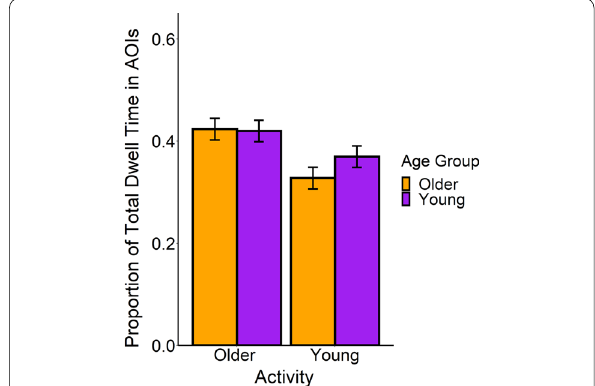
Fig. 3 Proportion of total dwell time spent in the goal-relevant AOIs. Young adults spent more time in the goal-relevant regions in the young adult activities, but older and young adults did not differ in their time spent looking at goal-relevant information in the older adult activities. Error bars represent 1 standard error around the estimated